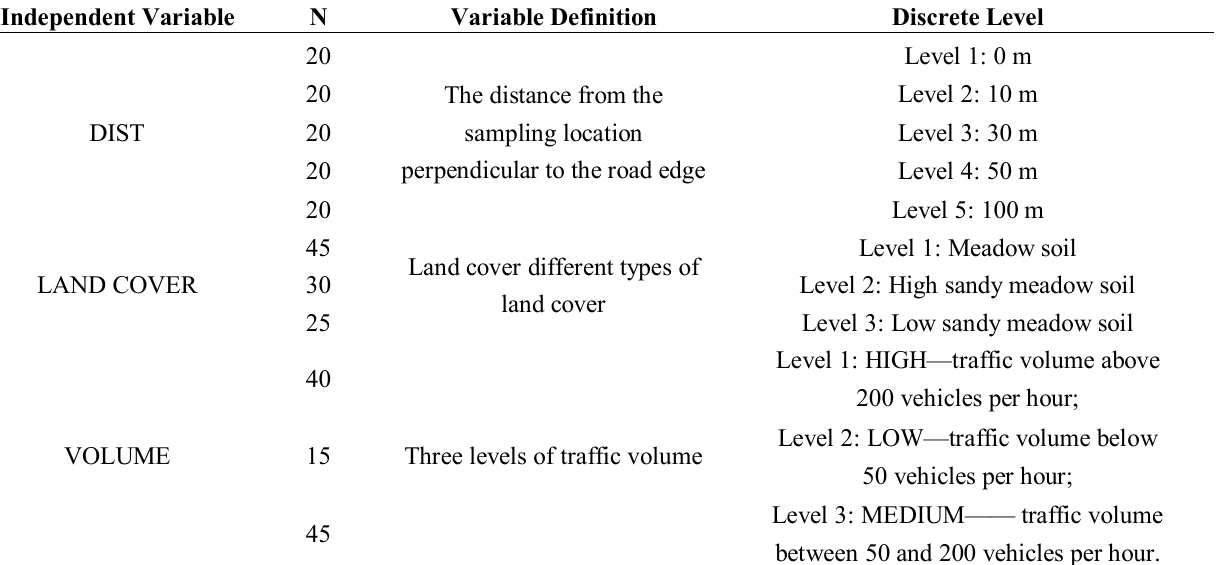
Table 2. Sample size and description of variables related to the soil